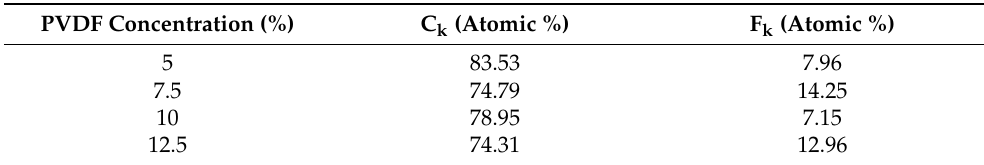
Table 1. Energy-dispersive spectroscopy (EDS) elemental composition of the fabricated freestanding electrodes at various PVDF concentration.